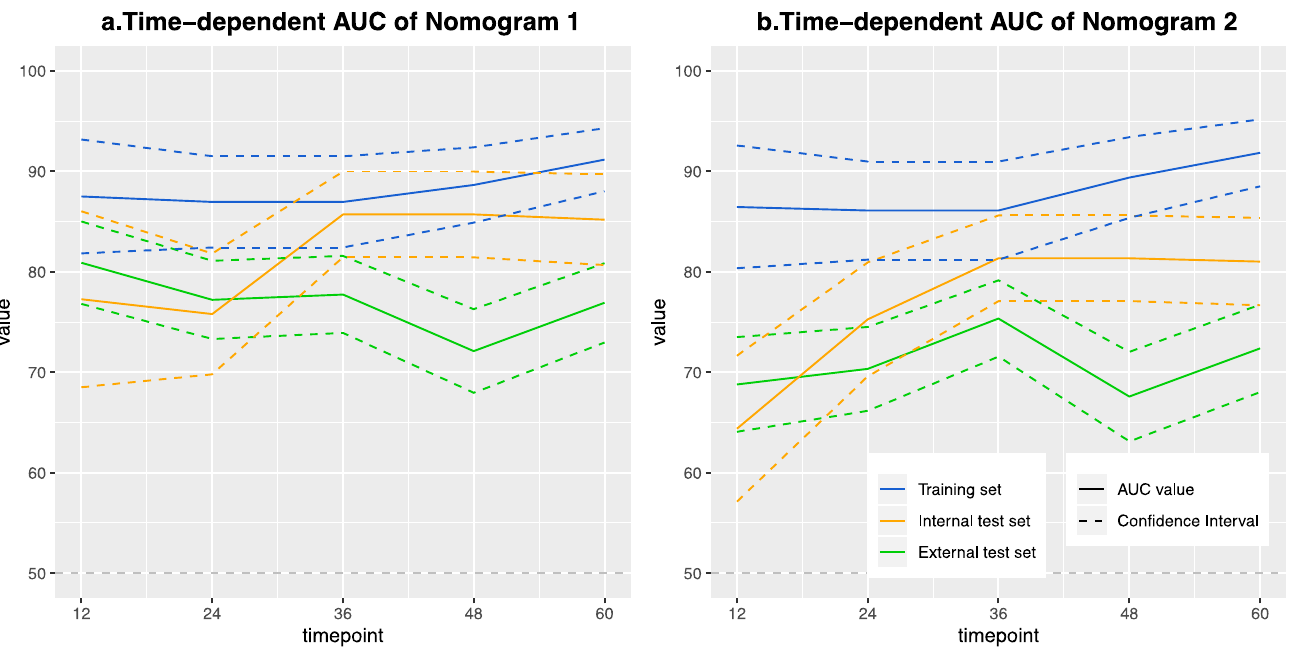
Figure 4. Time-dependent ROC curves for the nomograms in the training set (blue color), internal test set (yellow color), and external test set (green color). ROC, receiver operating characteristic. ( a ) Nomogram 1 with genomics feature selection. ( b ) Nomogram 2 without genomics feature selection. Dotted lines represent the 95% confidence interval (CI).